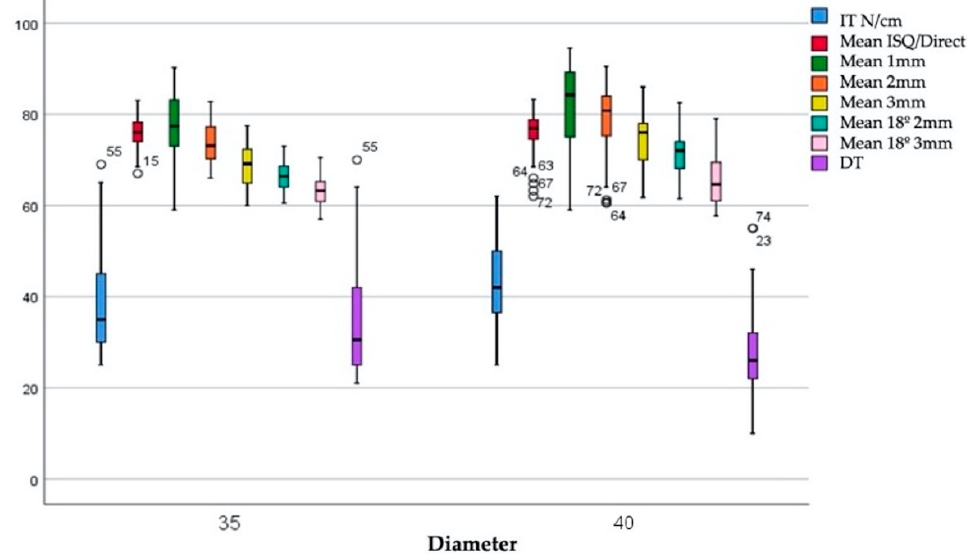
Figure 4. Insertion torque (IT) and disinsertion torque (DT). ISQ values with respect to the diameter.